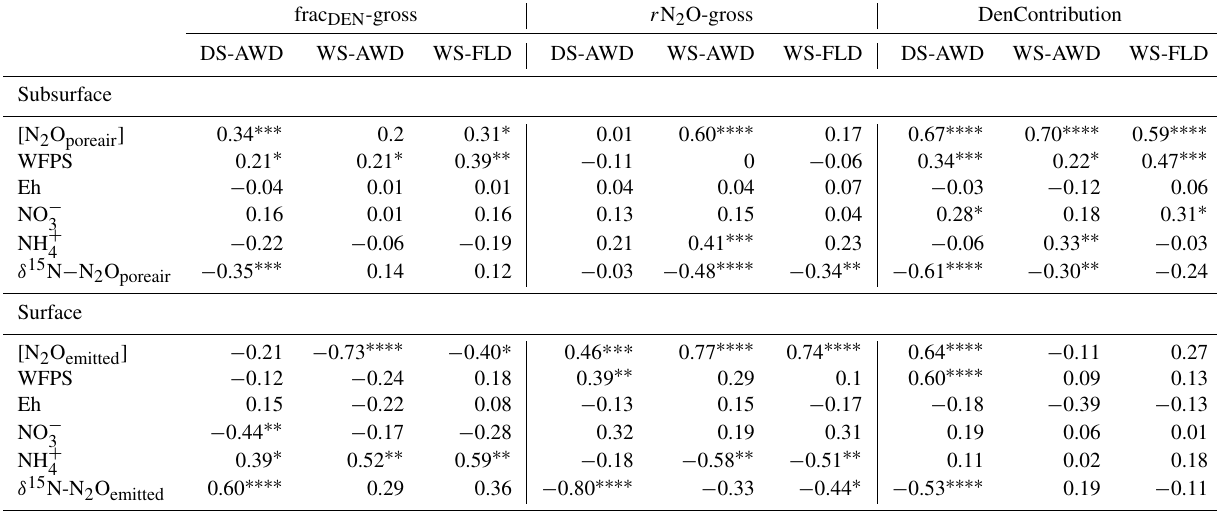
Table 6. Spearman correlations between modeled r N 2 O-gross, frac DEN -gross and DenContribution with soil environmental variables and in- organic N substrates and δ 15 N-N 2 O. Results are for the mean of open- and closed-system dynamics. Subsurface correlations were performed on data aggregated across 5 and 12.5cm depths. Significance indicated by ∗∗∗∗ <0.0001, ∗∗∗ <0.001, ∗∗ <0.01, ∗ <0.05. frac DEN -gross r N 2